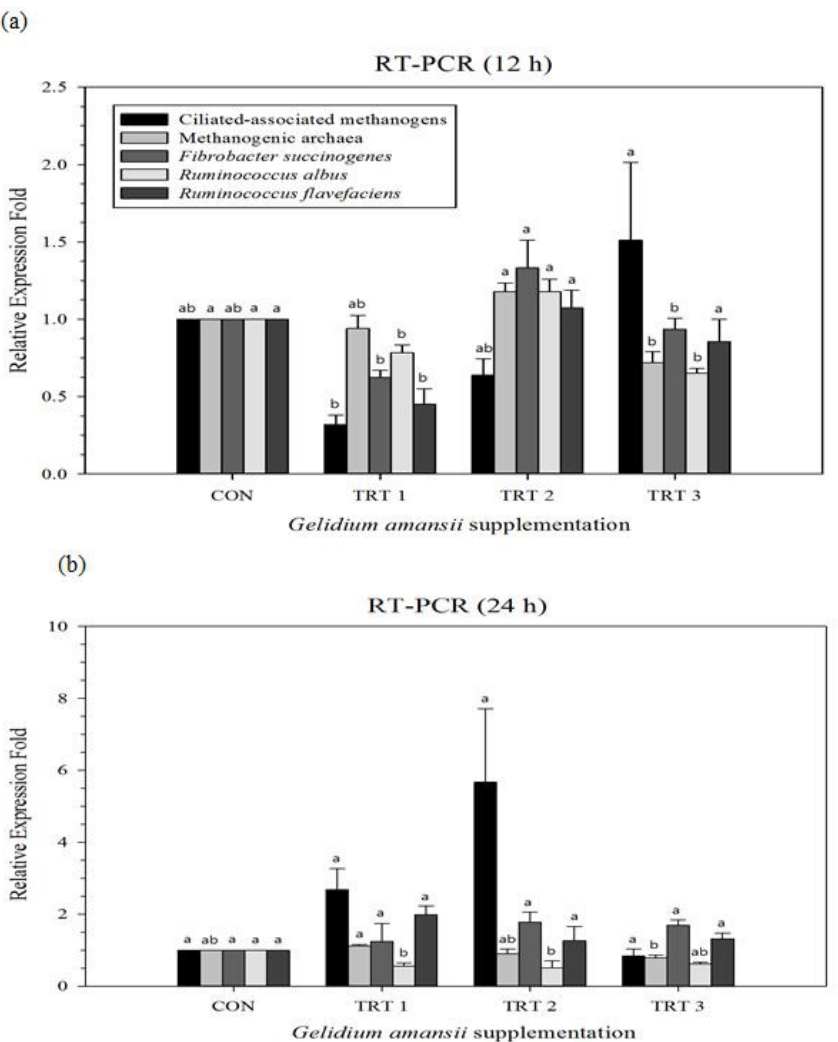
Figure 1. Relative quantification analysis of rumen microorganism populations under in vitro ruminal fermentation by the addition of marine alga Gelidium amansii after 12 h (a) and 24 h (b) incubation. Microorganism populations examined include ciliate-associated methanogens, methanogenic archaea, and cellulolytic bacteria (Fibrobacter succinogenes, Ruminococcus albus, and Ruminococcus flavefaciens). Dietary treatments were as follows: CON, basal diet (without G. amansii); TRT 1, CON+1% G. amansii; TRT 2, CON+3% G. amansii; TRT 3, CON+5% G. amansii as basis of substrate (timothy). ab Means with different superscripts in the same row differ significantly